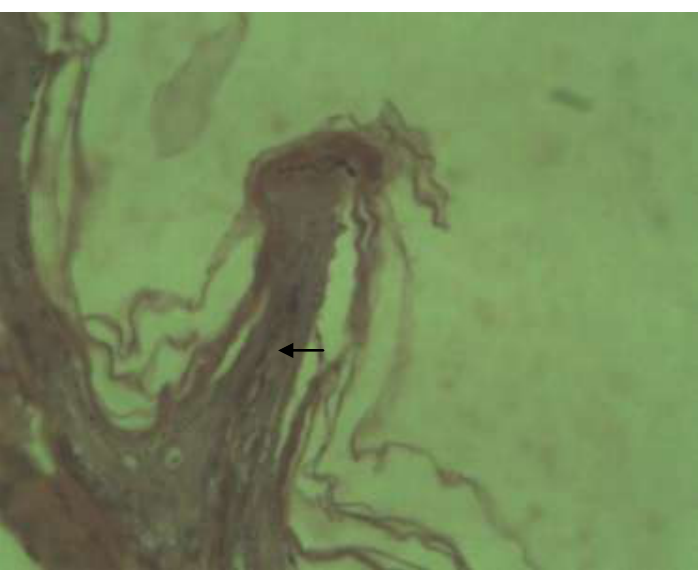
Figure (1): Stomach hyperplasia of epithelia lining no glandular stomach (H and E X400)